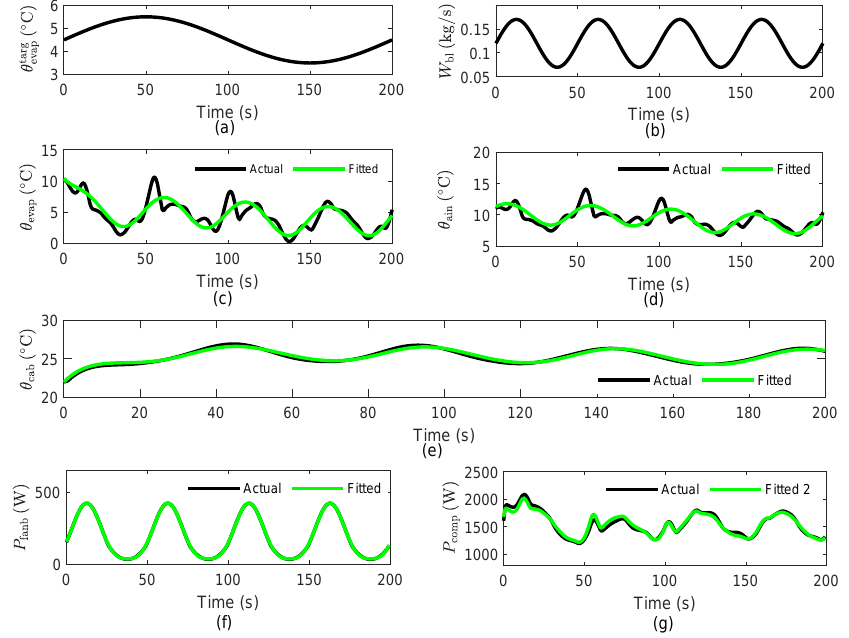
Figure 4. Validation of the control-oriented AC model. Sinusoidal inputs to the AC system: ( a ) the target temperature of the wall of the evaporator and ( b ) the flow rate of the blower air. Outputs include ( c ) the temperature of the evaporator, ( d ) the air inlet temperature into the cabin, and ( e ) the air temperature in the cabin, as well as the power of two components: ( f ) the evaporator blower and ( g ) the